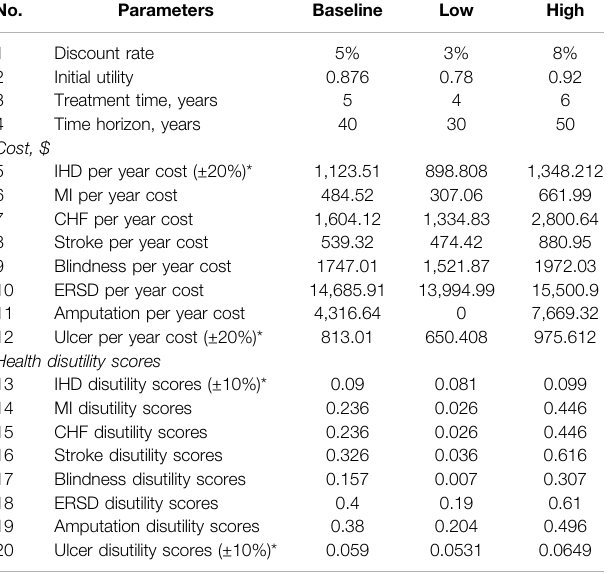
TABLE 4 | Parameters for sensitivity